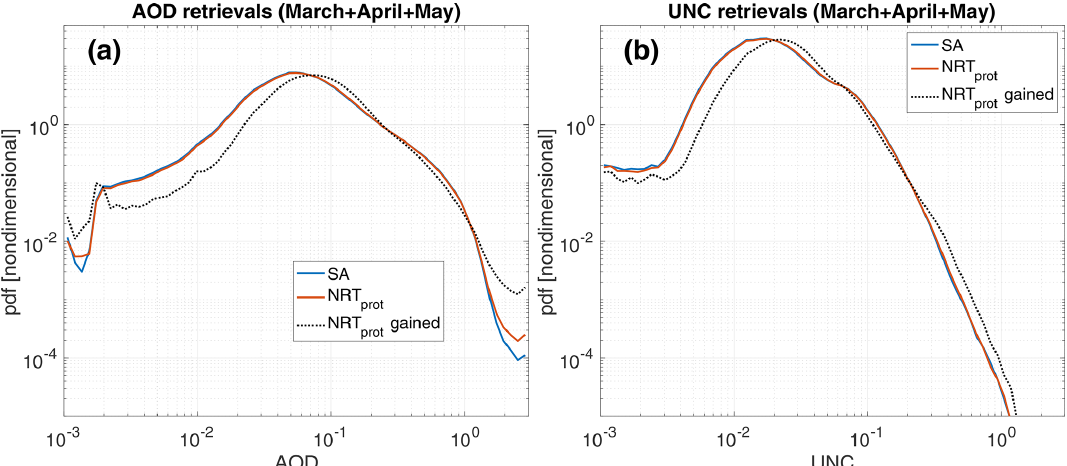
Figure 2. (a) AOD normalized probability density functions from SA, prototype NRT, and prototype NRT retrievals that do not have a matching SA equivalent (labeled as NRT prot gained). (b) Same as in (a) , but for retrieved AOD uncertainties (UNC). Data statistics for AODs are provided in Table 1.